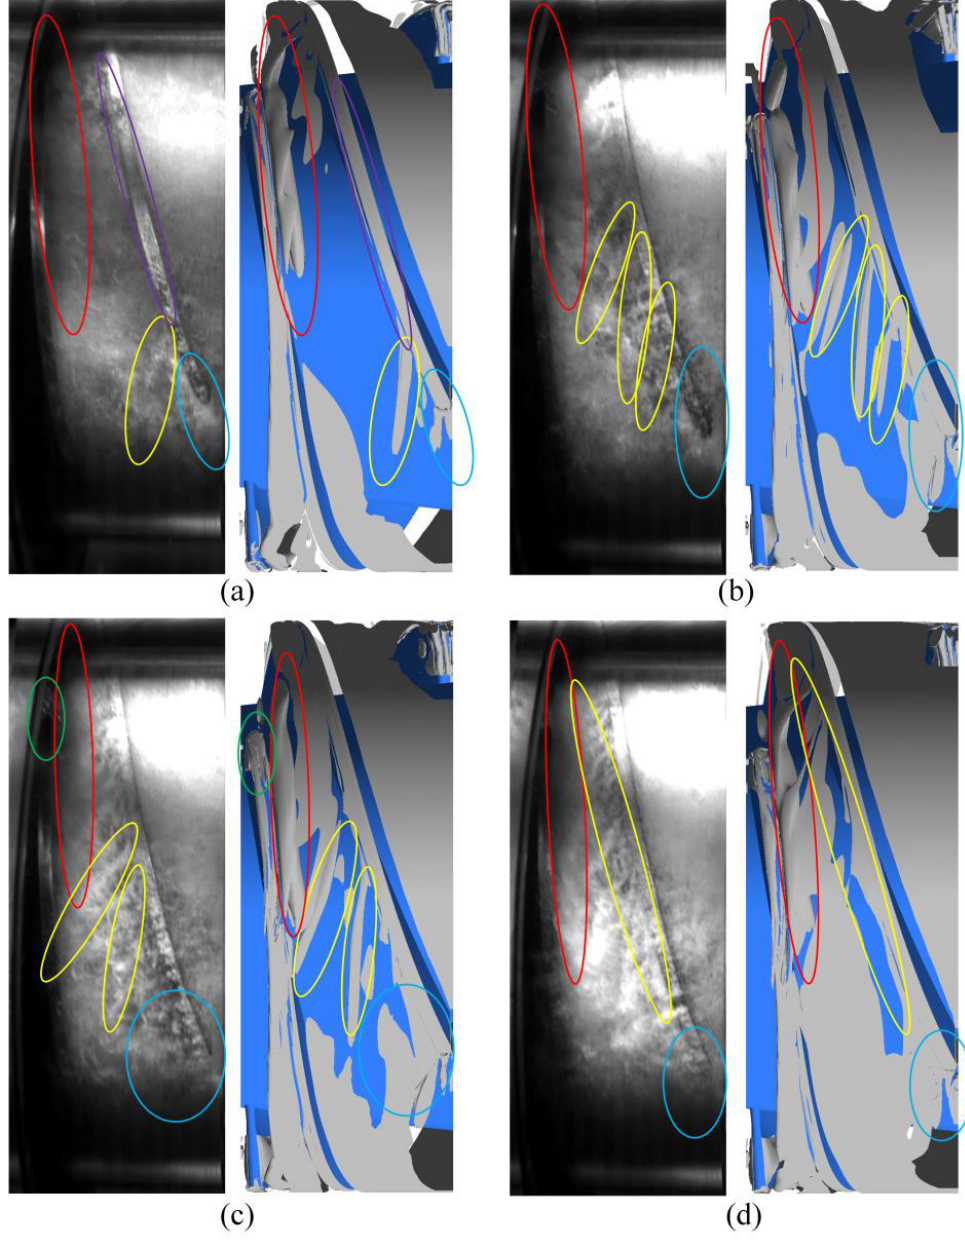
Figure 6. Flow pattern of TLV. ( a ) IGVF = 5%; ( b ) IGVF = 10%; ( c ) IGVF = 15%; and ( d ) IGVF = 20%. The red, yellow, purple, green, and blue circles denote PTLV, STLV, TSV, LV, and TV, respectively.